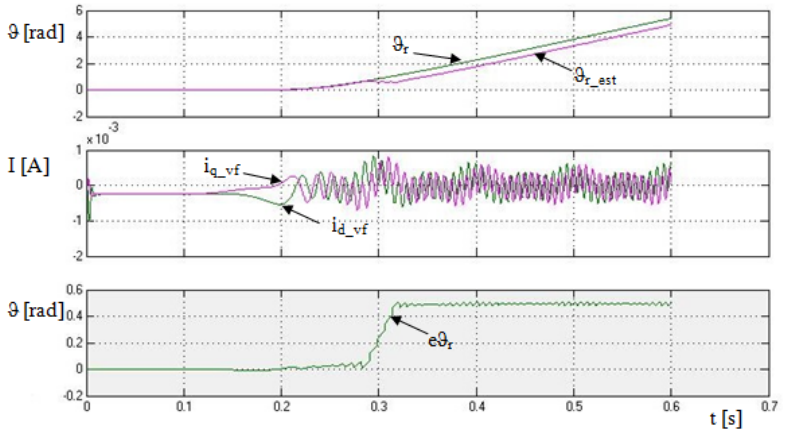
Figure 17. Rotor position estimation prior to NSS filtering .